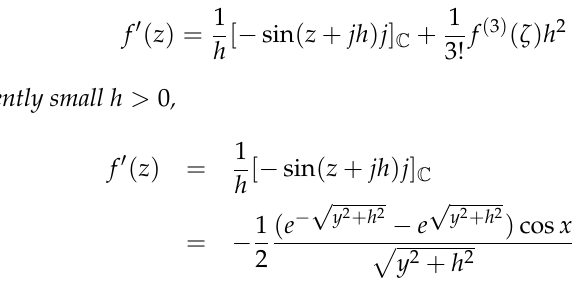
. It confirms to us how close the relative 2